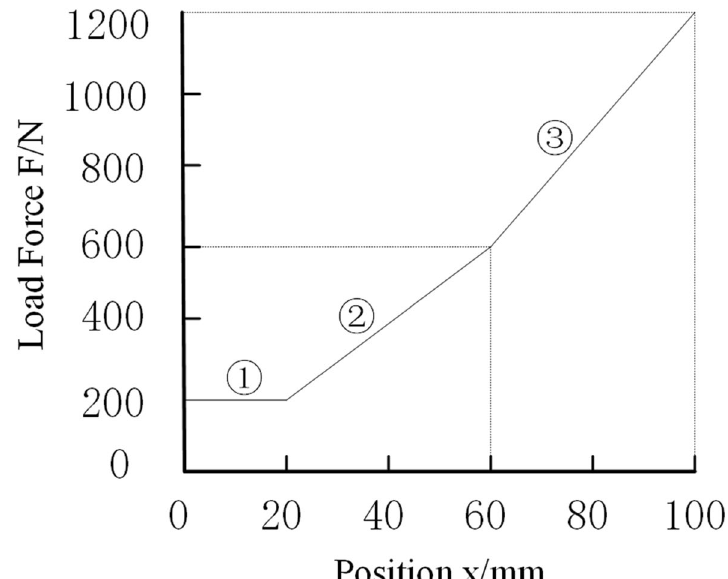
Fig. 4 Simulation load setting